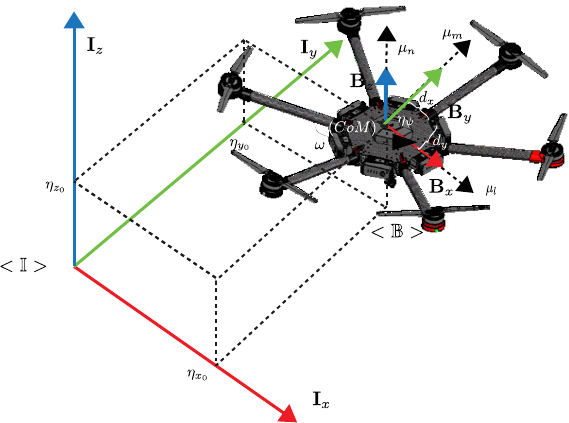
Figure 1. Hexacopter platform